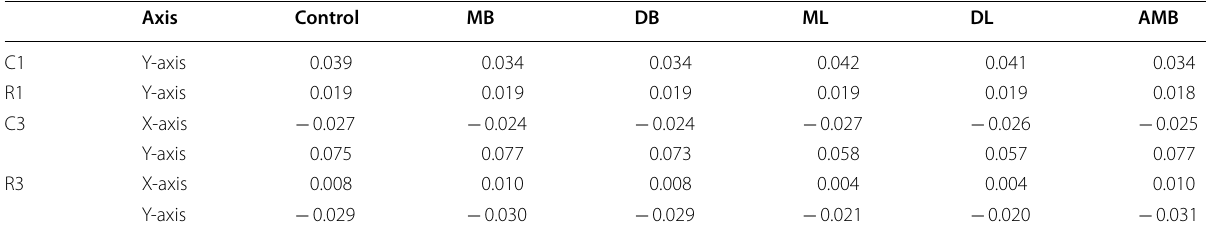
Table 4 Displacements of the central incisor in the y-direction and of the canine in the x- and y-directions (mm)